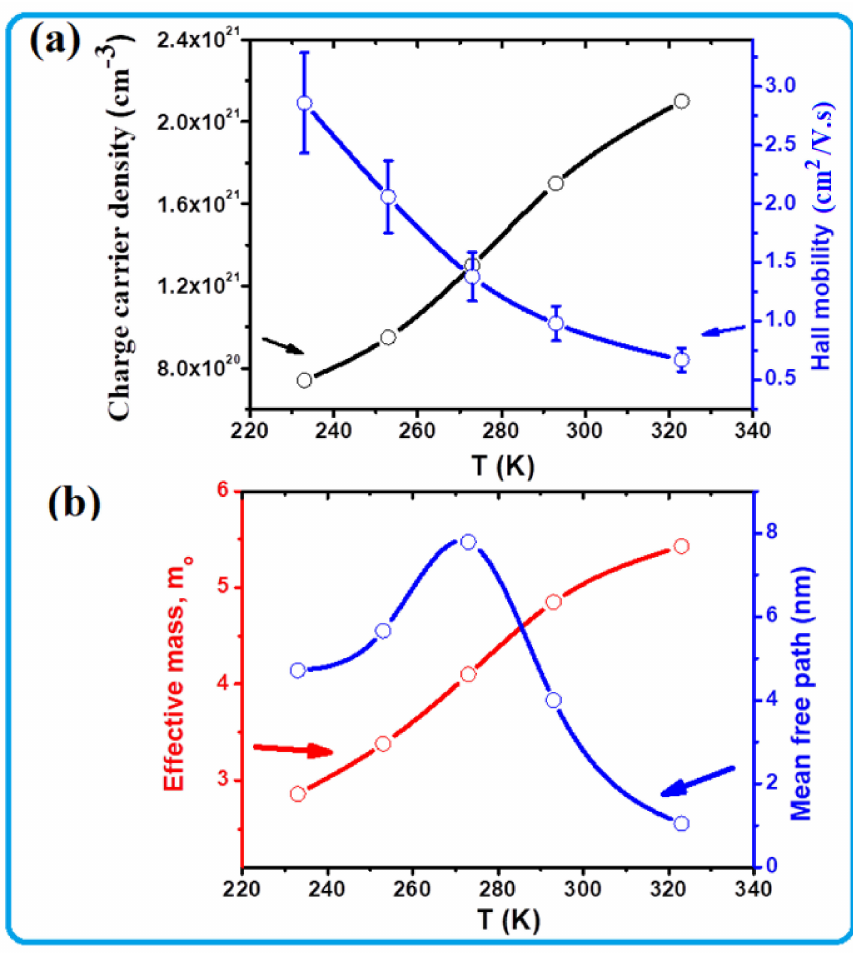
Figure 6. ( a ) Charge carrier density, Hall mobility, and ( b ) effective mass and mean free path of the free charge carriers in TOS as a function of